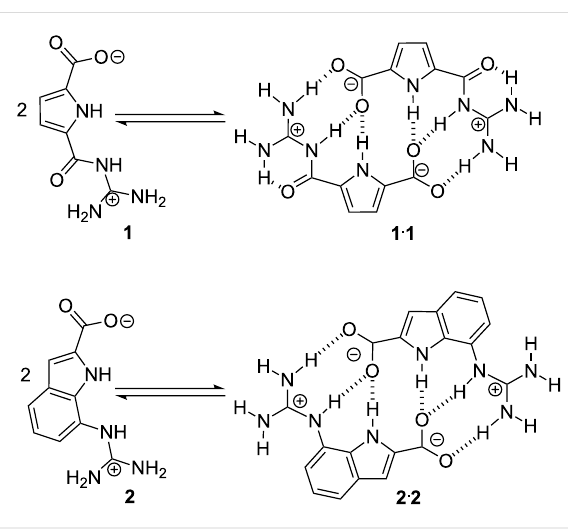
Figure 1: Self-assembly of zwitterion 1 to give dimer 1 · 1 and self- assembly of zwitterion 2 to give dimer 2 · 2 – both using the same inter- molecular interactions: a pattern of six H-bonds and two salt